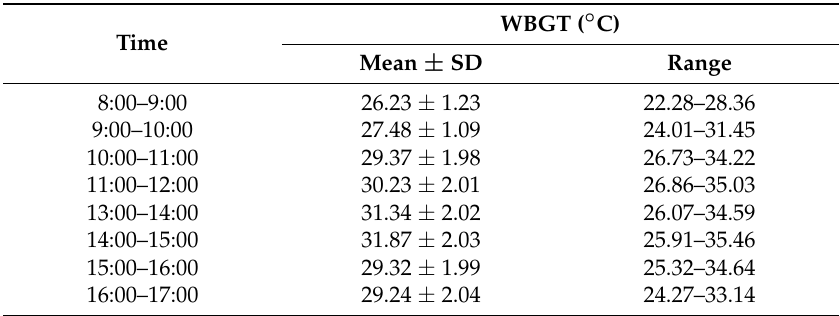
Table 2. Descriptive statistics of the WBGT data in morning and afternoon work sessions.